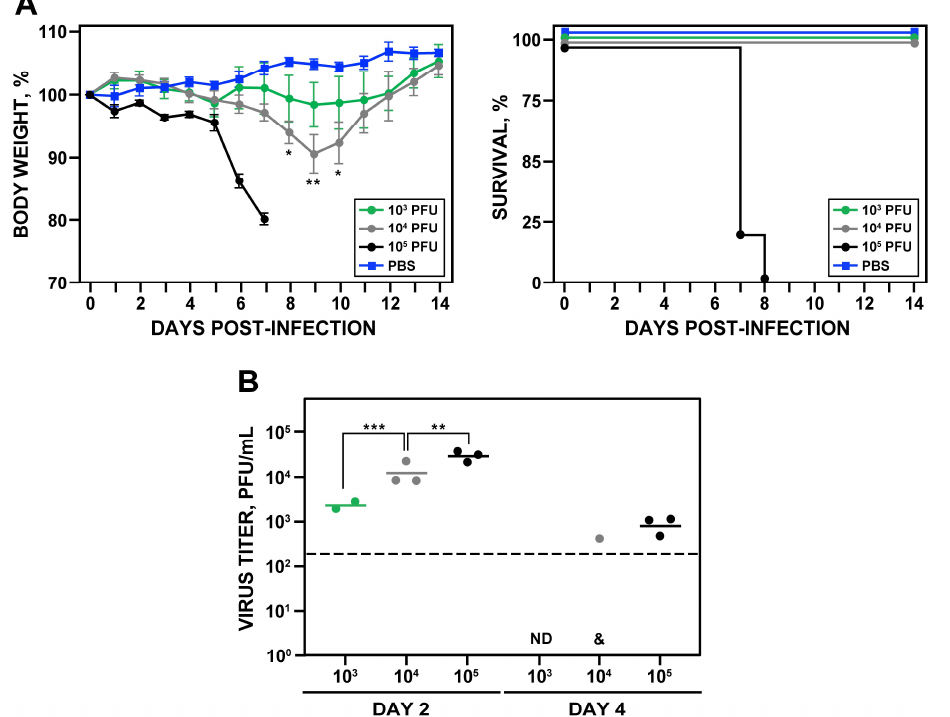
Figure 4. Pathogenesis of rZIKV-RGN in A129 mice. ( A ) Weight loss and mortality. Female 4-to-6-